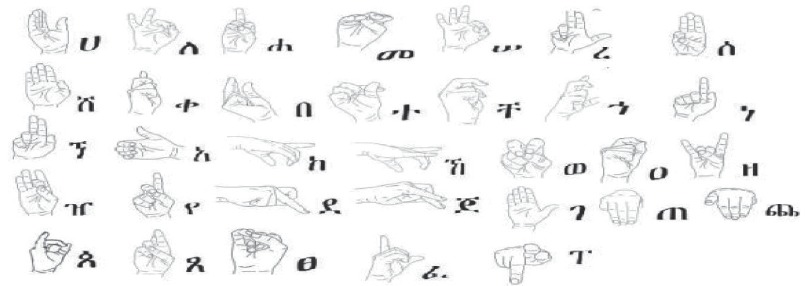
Figure 1: Ethiopian finger spelling for EthSL